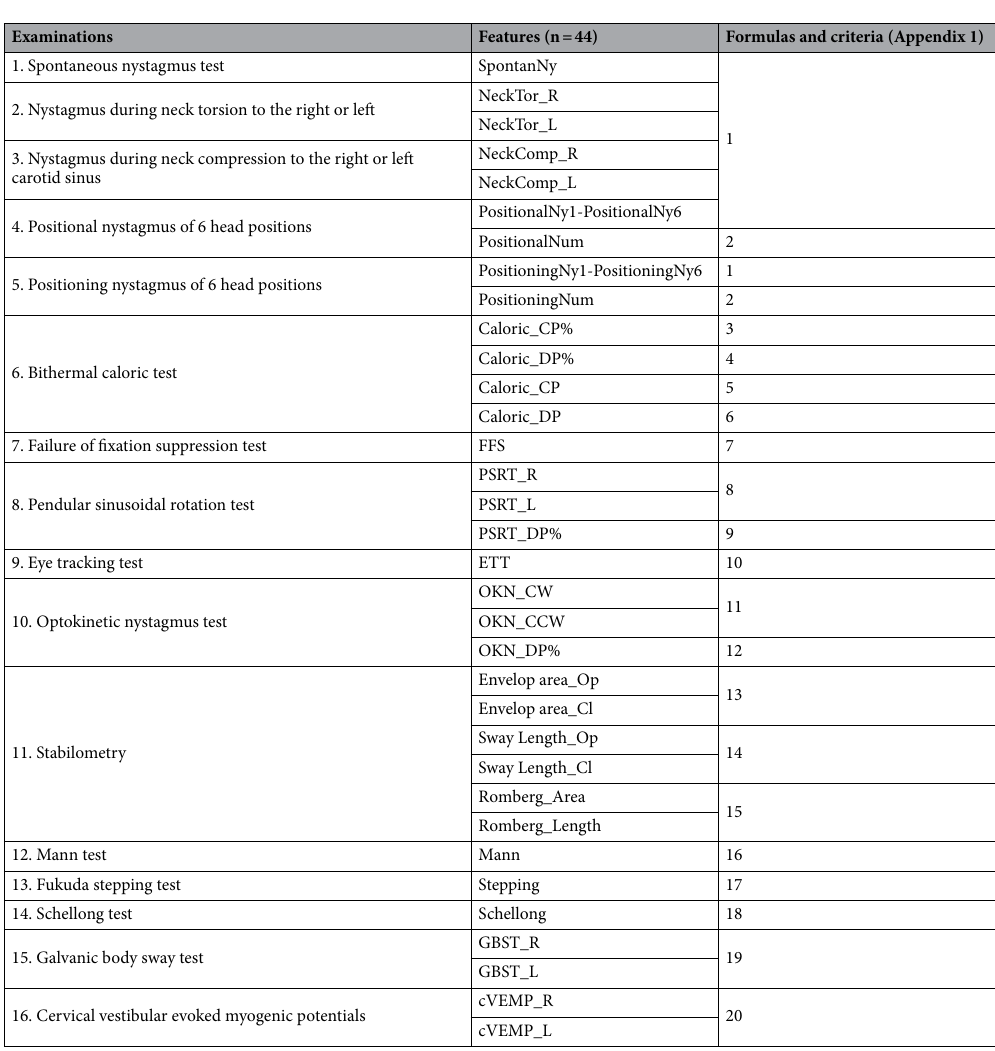
Table 2. Equilibrium examinations and each feature’s name. Ny nystagmus, R right, L left, CP canal paresis, DP directional preponderance, MSPV maximal slow phase velocity (degree/second), FFS failure of fixation suppression test, PSRT pendular sinusoidal rotation test, ETT eye tracking test, OKN optokinetic nystagmus, CW or CCW clockwise or counterclockwise, Op open, Cl close, GBST galvanic body sway test, cVEMP cervical vestibular evoked myogenic